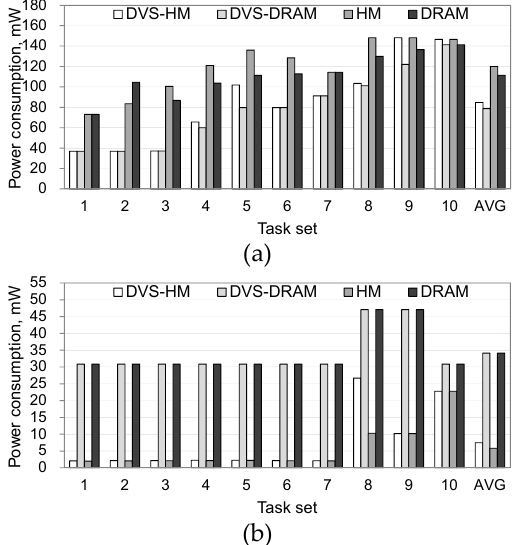
Figure 3. Processor and memory power consumption under synthetic workloads. ( a ) Power consumption in processor, ( b ) power consumption in memory. DVS-HM = dynamic voltage scaling with hybrid memory; DVS-DRAM = dynamic voltage scaling with dynamic random access memory; HM = hybrid memory; DRAM = dynamic random access memory.